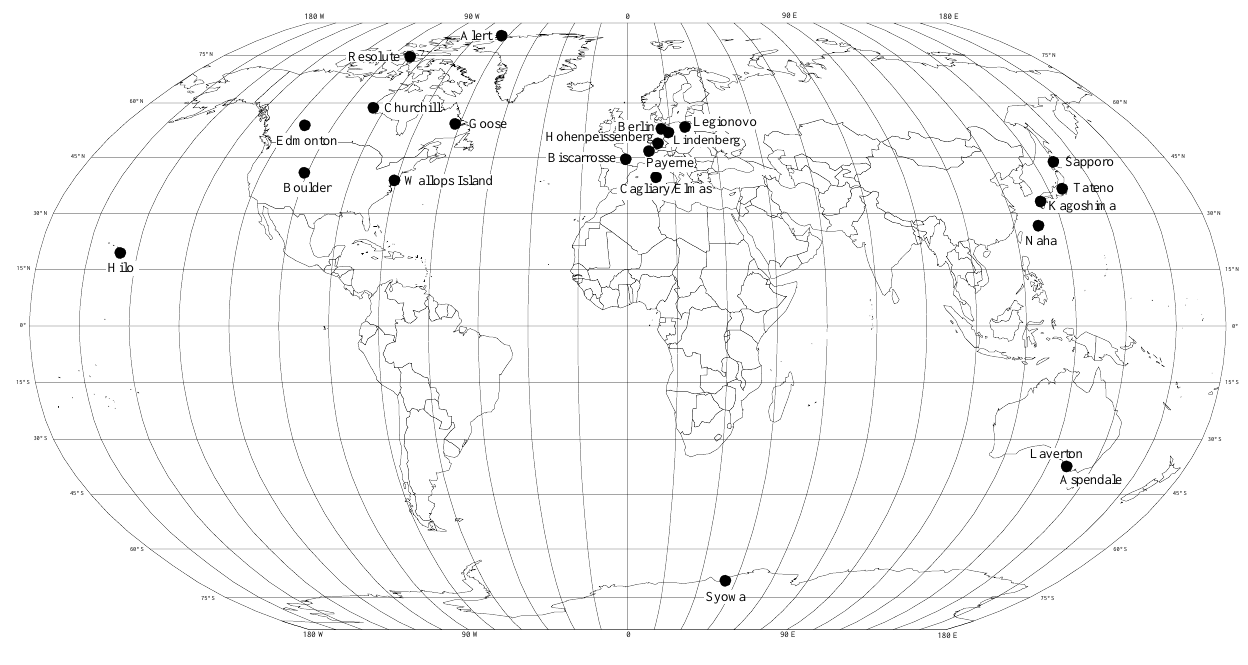
Figure 1. Location of Ozonesonde Stations Used in This Work Fig. 1. Geographic location of the ozonesonde stations used in this work. Table 1. Indicators of monthly means of ozone, temperature and wind profiles utilized.